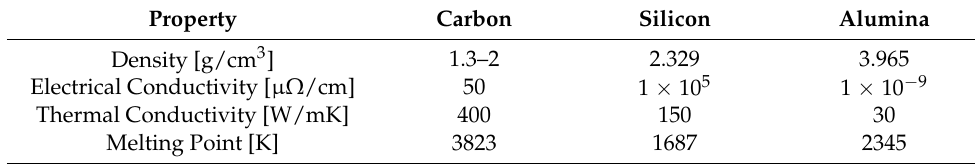
Figure 4. Particle size distribution of ( a ) silicon and ( b ) alumina used in this study. Table 2. Properties of different